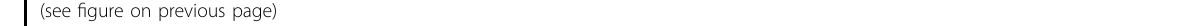
Fig. 3 FBXW7 negatively regulates CHD6 stability. a Sequence alignment of the putative FBXW7-recognized degron on CHD6. [LIVMP] refers to a group of amino acids, Leu, Ile, Val, Met, Pro, are all allowed; {0,2}, 0, 1, and 2 positions of any kind of amino acids; (T), phosphorylated Thr;.., any kinds of amino acids. b Representative immunoblots showing CHD6 steady-state expression in HCT116 cells upon FBXW7 overexpression or KD. c The interaction between exogenous FBXW7 and CHD6 was determined by co-IP assay. 293T cells were transfected with Myc-tagged CHD6 and Flag- tagged FBXW7. The cell lysates were pulled down with Myc-tagged magnet beads and immunoblotted with the indicated antibodies. WCL: whole cell lysates. d The interaction between endogenous FBXW7 and CHD6 was determined by co-IP assay. HCT116 cell lysates were pulled down with an anti-CHD6 antibody and immunoblotted with FBXW7. e Representative immunoblots showing CHD6 protein turnover rate in HCT116 cells, with or without FBXW7 overexpression (left). Quanti fi cation of CHD6 turnover rate (right). Cells were transfected with the indicated plasmids in the presence of CHX (60 μ g/mL) for the indicated times. CHD6 levels were normalized to Vinculin and then normalized to the t = 0 control. f 293T cells were transfected with the indicated plasmids and treated with MG132 (10 μ M) 6 h before harvest. The cell lysates were pulled down with nickel beads and immunoblotted with an anti-Myc antibody. g , h Representative immunoblots showing the turnover rate of Flag-tagged CHD6 WT or Flag-tagged CHD6 T2127A/T2131A, with or without Myc-tagged FBXW7 overexpression in 293T cells ( g ). Quanti fi cation of CHD6 turnover rate ( h ). Transfected cells were treated with CHX (60 μ g/mL) for the indicated times. Flag-tagged CHD6 levels were fi rst normalized to Vinculin, and then to the t = 0 control. i 293T cells were transfected with the indicated plasmids and treated with MG132 (10 μ M) 6 h before harvest. The cell lysates were pulled down with nickel beads and immunoblotted with an anti-Flag antibody. j 293T cells were transfected with the indicated plasmids. The cell lysates were immunoblotted with the indicated antibodies. k Representative immunoblots showing the turnover rate of Flag-tagged CHD6 WT or Flag- tagged CHD6 P2128L, with or without Myc-tagged FBXW7 overexpression in 293T cells (left). Transfected 293T cells were treated with CHX (60 μ g/ mL) for the indicated times. Quanti fi cation of CHD6 WT and P2128L mutant turnover rate (right). Flag-tagged CHD6 levels were fi rst normalized to Vinculin, and then to the t = 0